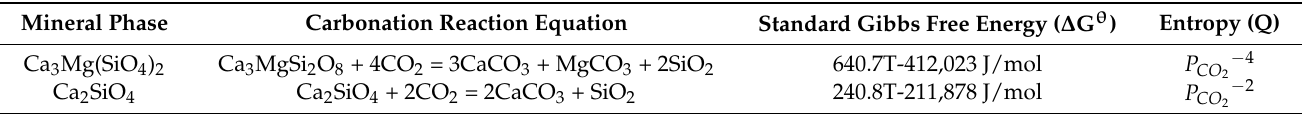
Table 2. Carbonation reaction equations of carbonatable phases in the EAF slag. Mineral Phase